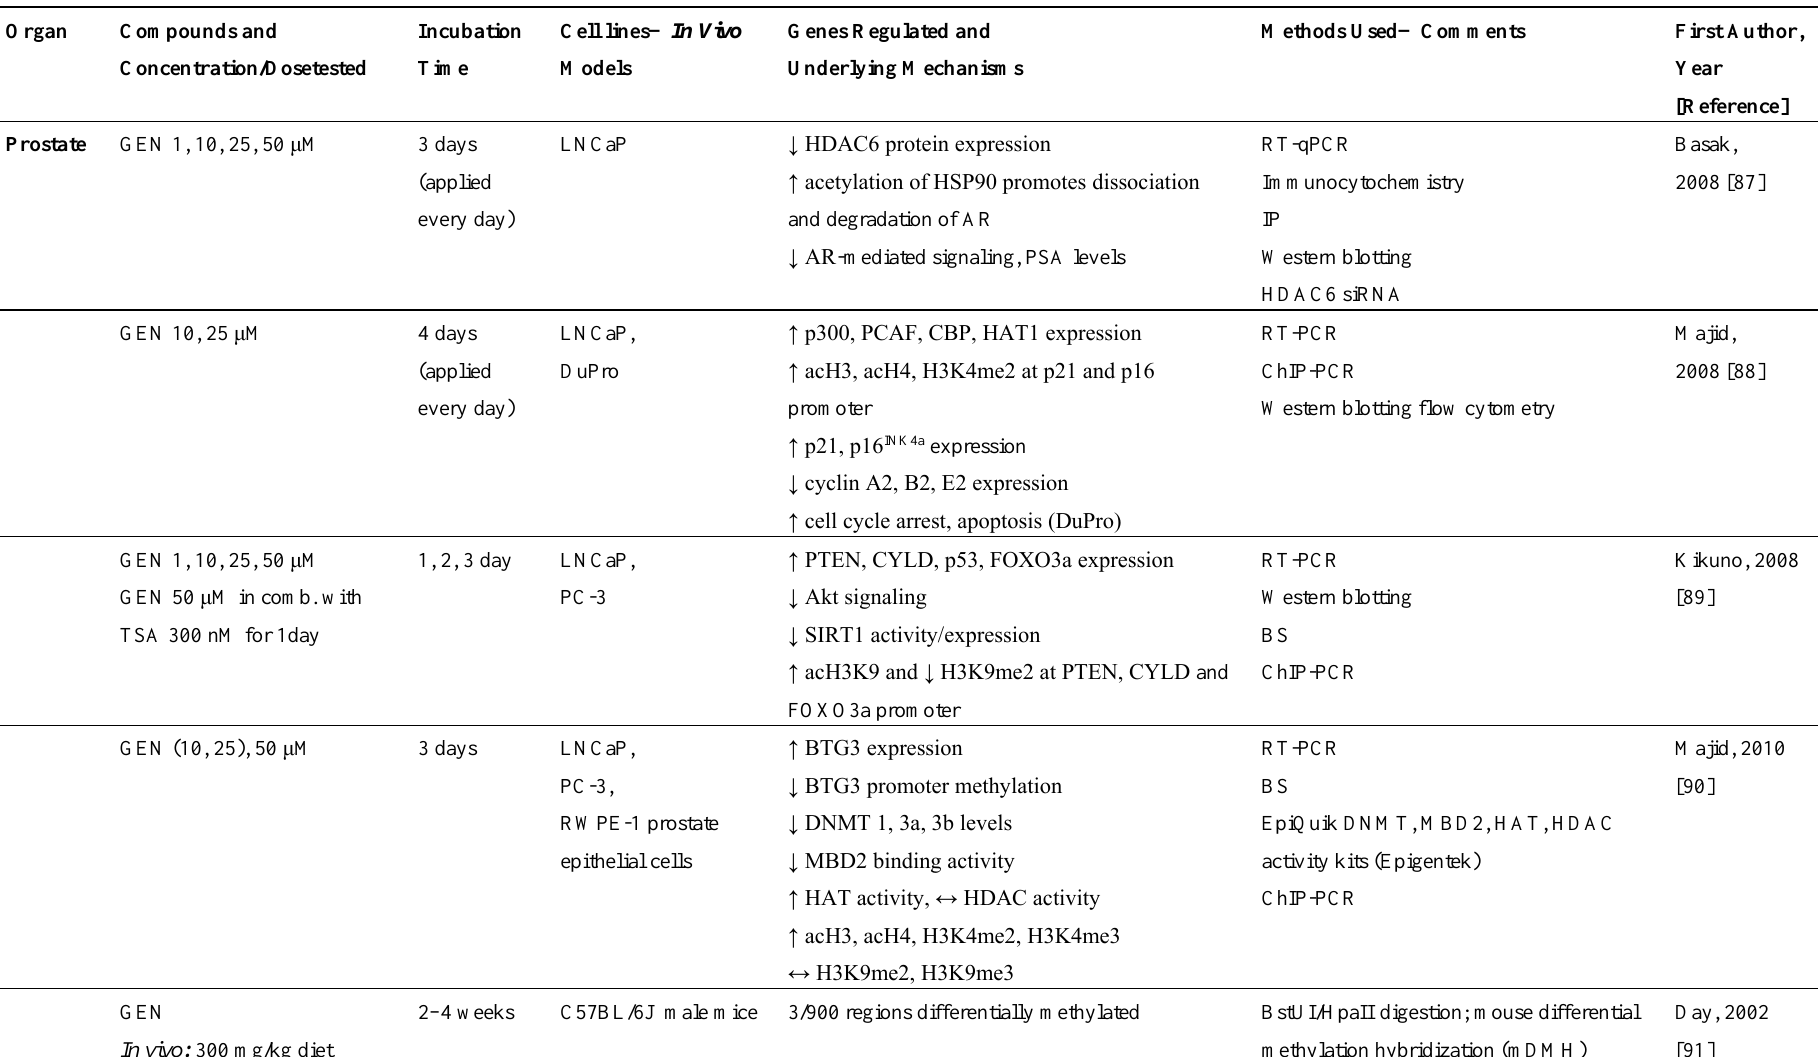
Table 3. Soy isoflavones targeting epigenetic mechanisms in the urogenital system in vitro and in vivo